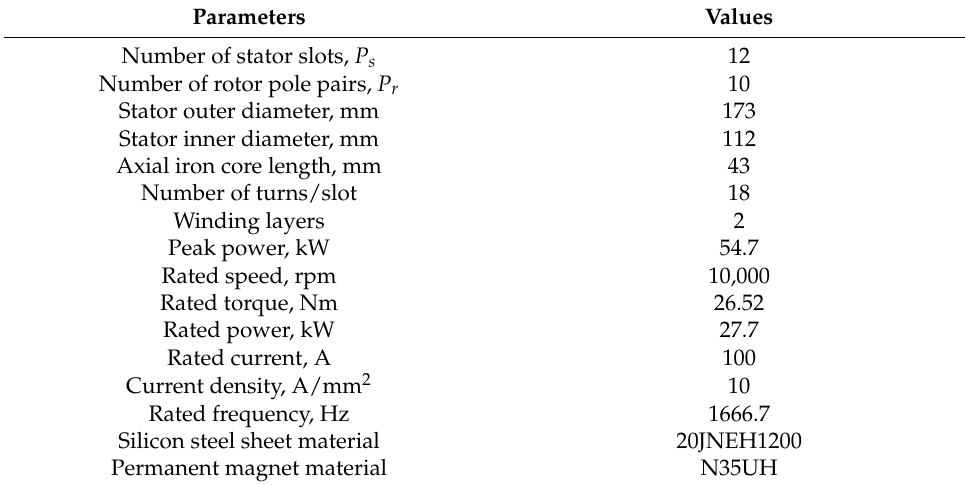
Figure 1. Cross-section of a 12/10 FSPM machine and eight key points. ( a ) 2D machine cross-section, ( b ) eight key points. Table 1. Main parameters of the 12/10 FSPM machine.